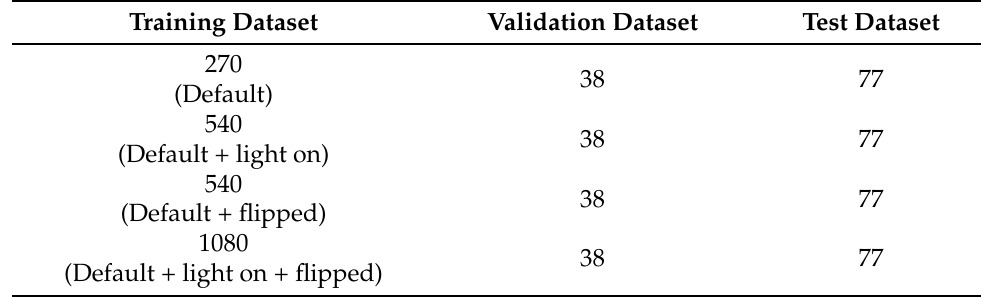
Table 4. The number of images used for training, validation, and test